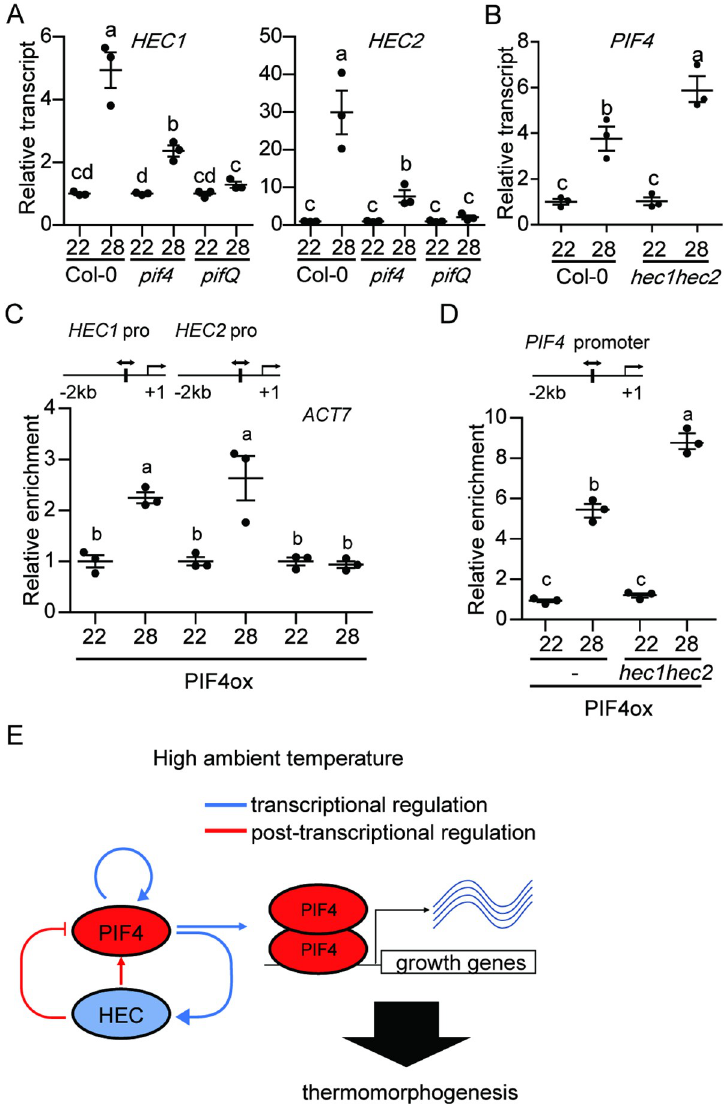
Fig 6. An autoregulatory negative feedback module controls thermomorphogenesis. (A) PIFs activate the expression of HEC1 and HEC2 . RT-qPCR analysis of HEC1 and HEC2 gene expression using Col-0, pif4 and pifQ mutant. (B) HECs inhibit the expression of PIF4 under high ambient temperature. RT-qPCR analysis of PIF4 using Col-0 and hec1hec2 mutant. Relative gene expression levels were normalized using expression levels of ACT7 . (C) PIF4 directly activates the expression of HEC s. ChIP-qPCR analysis of PIF4 binding to the HEC1 and HEC2 promoter region using 35S:PIF4-myc in Col-0 background. ACT7 was used for the control. (D) PIF4 activates its own expression in a HEC-dependent manner. ChIP-qPCR analysis of PIF4 promoter region using 35S:PIF4-myc in Col-0 and hec1hec2 backgrounds. For both RT-qPCR and ChIP-qPCR samples, whole seedlings grown for 5 days at 22˚C and then either kept at 22˚C or transferred to 28˚C for 4 hours. Three biological repeats were performed. The letters a-c indicate statistically significant differences based on one-way ANOVA analysis with Tukey’s HSD test. Simple genomic region scheme is described with PIF4 binding motif in vertical line. (D) Simplified model shows the role of an autoregulatory module controlling thermomorphogenesis. At high ambient temperature, PIF4 activates the expression of both PIF4 and HEC s by transcriptional regulation. HECs heterodimerize with PIF4 and inhibit PIF4 function which regulates growth genes at transcriptional